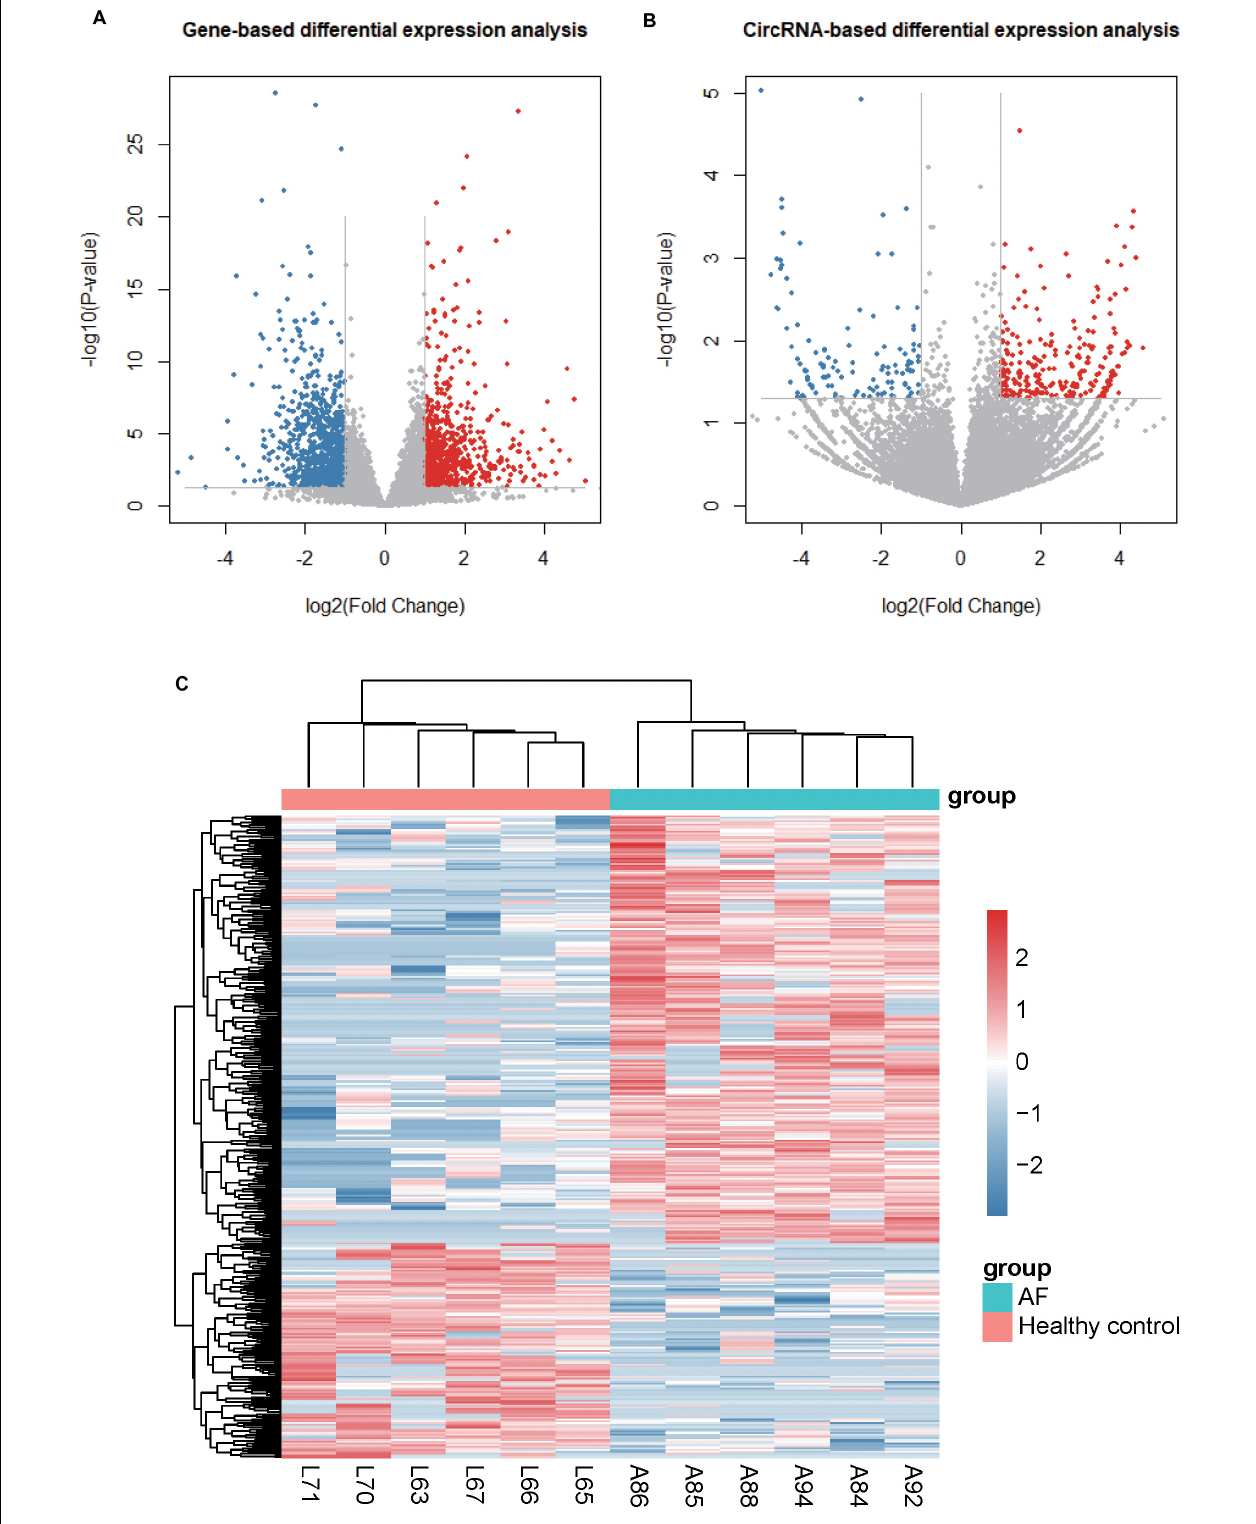
FIGURE 2 | Differentially expressed genes and circRNAs. (A) and (B) display the volcano plots for gene- and circRNA-based differential expression analysis, respectively. (C) The dysregulated circRNAs and samples are co-clustered by hierarchical clustering analysis. The count-based expression levels are normalized, log2-transformed and scaled by